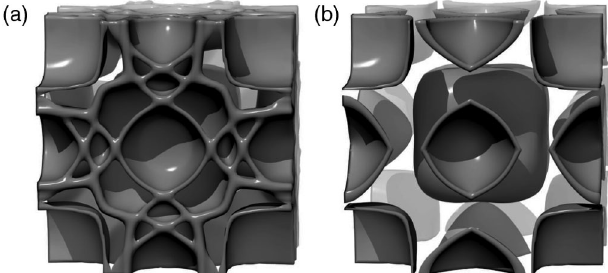
FIG. 5. Fermi surface of magnetite in the cubic phase. (a) Total (multiband) Fermi surface of magnetite as derived from the spin- polarized electronic band structure using the W IEN 2 K code, (b) isolated minority-spin t 2 band of interest. g